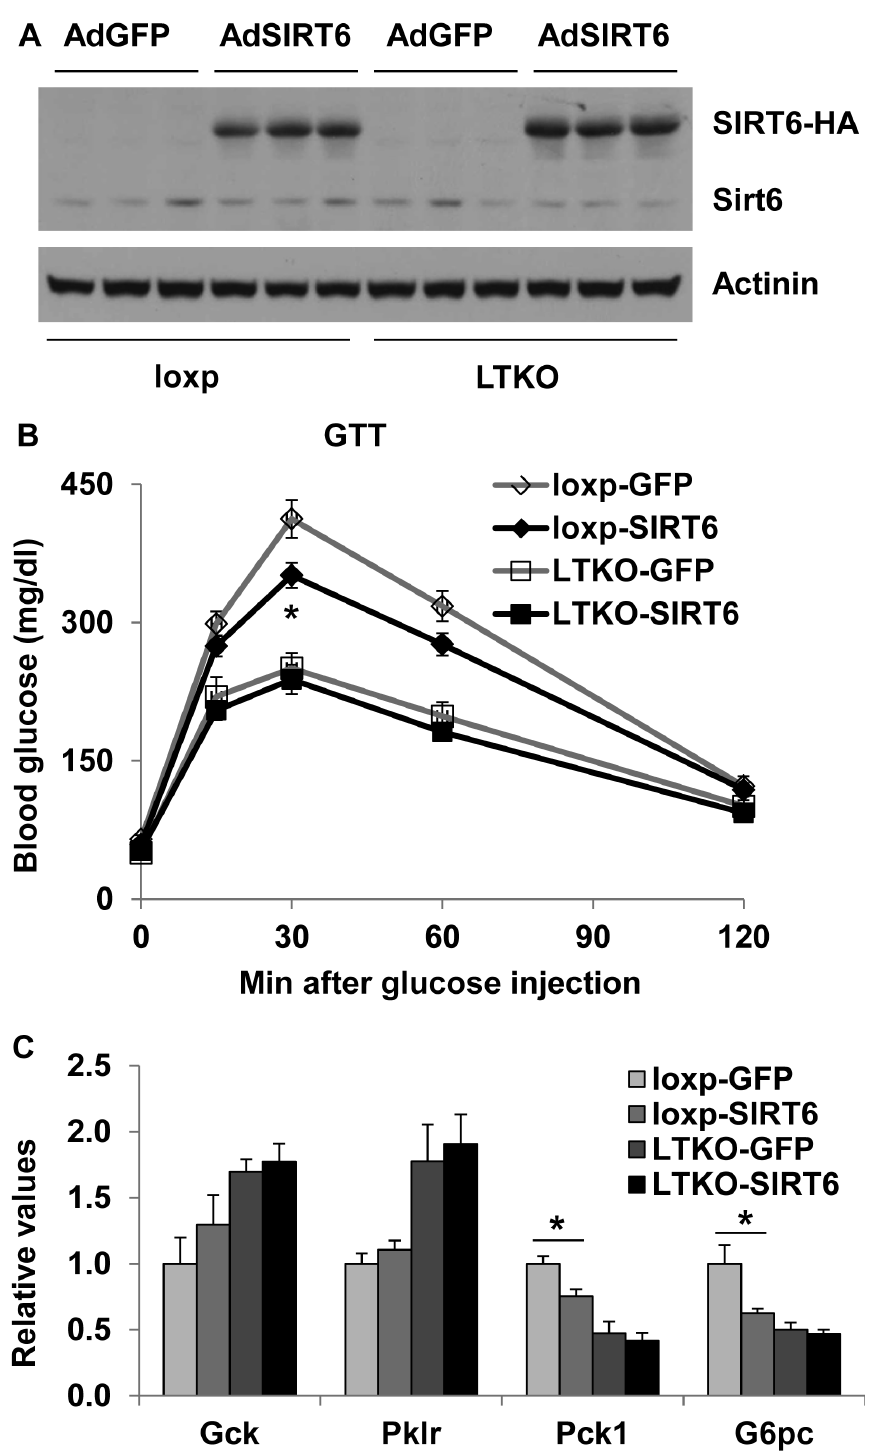
Figure 6. Sirt6 overexpression has no significant effect on glucose toerance in LTKO mice. (A) Sirt6 overexpression was assessed by Western blot analysis in liver lysates from control and LTKO mice injected with SIRT6 or GFP adenoviruses (n=6). (B) Glucose tolerance tests in 4-month-old control and LTKO mice injected with SIRT6 or GFP adenoviruses (n=6). (C) Expression of genes involved in glucose metabolism was analyzed in the livers of SIRT6 or GFP adenovirus infected control and LTKO mice (n=6) by real-time PCR. Data represent mean ± SEM. * indicates a significance with P <0.05 between loxp-GFP and loxp-SIRT6 groups. doi: 10.1371/journal.pone.0074340.g006 PLOS ONE |